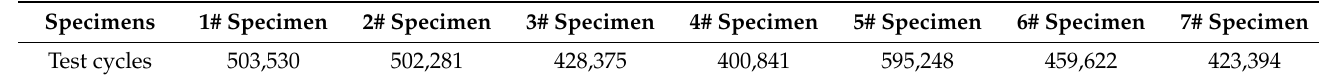
Table 2. Results of fatigue test under variable spectrum.